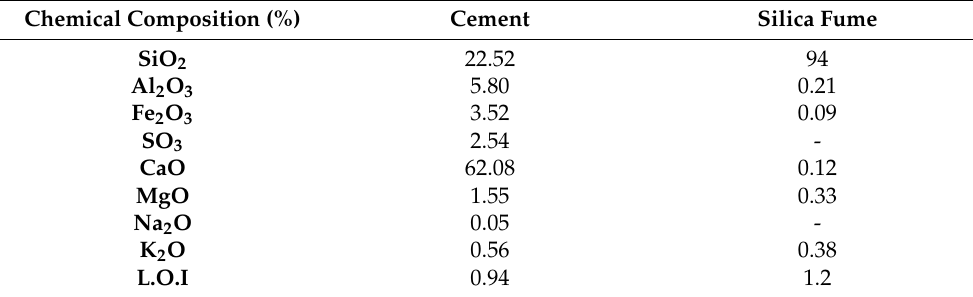
Table 1. Chemical compositions of cement and silica fume.